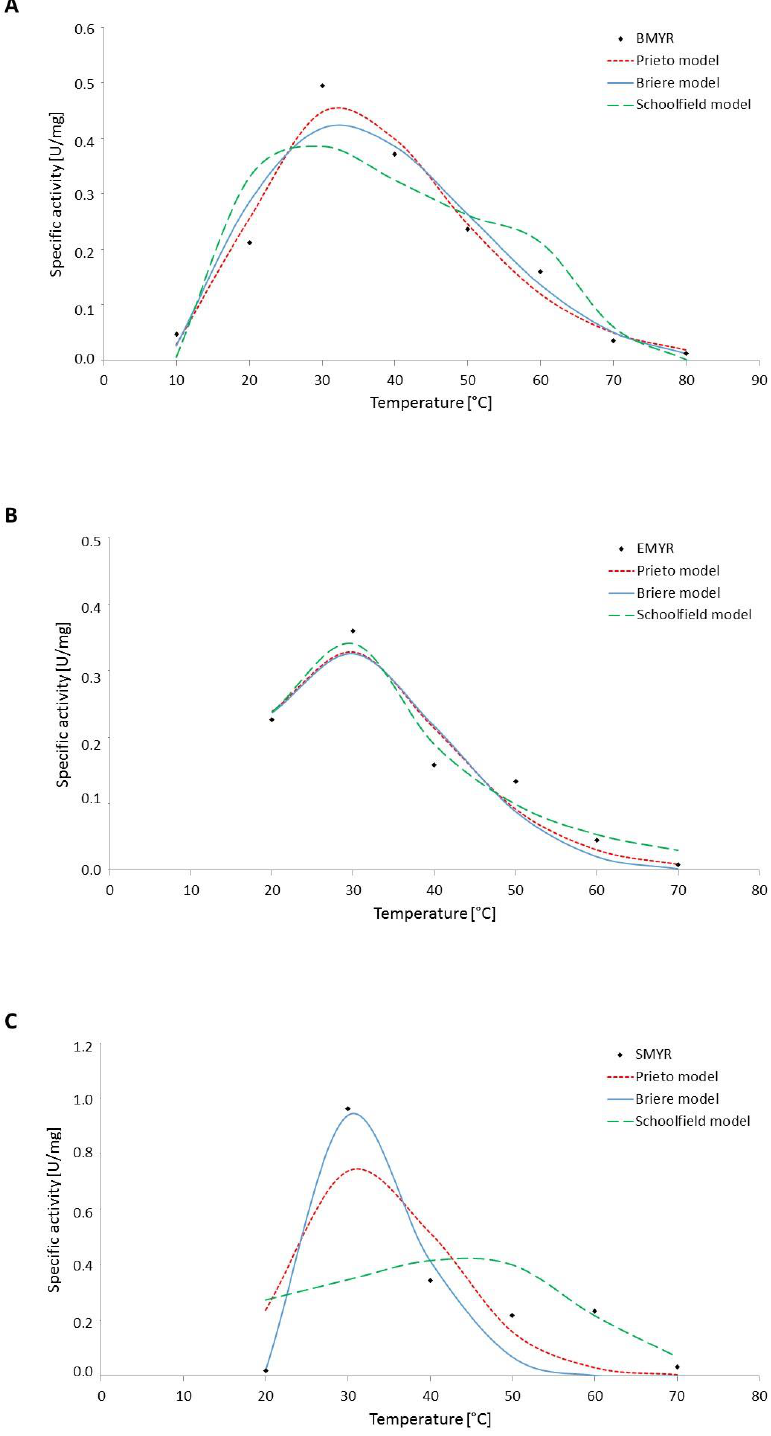
Figure 3. Adjustment of Prieto, Briere, and Schoolfield models to kinetic data of ( A ) BMYR, ( B ) EMYR, and ( C ) SMYR. Reactions were conducted at pH 7.0 and 100 μM sinigrin.